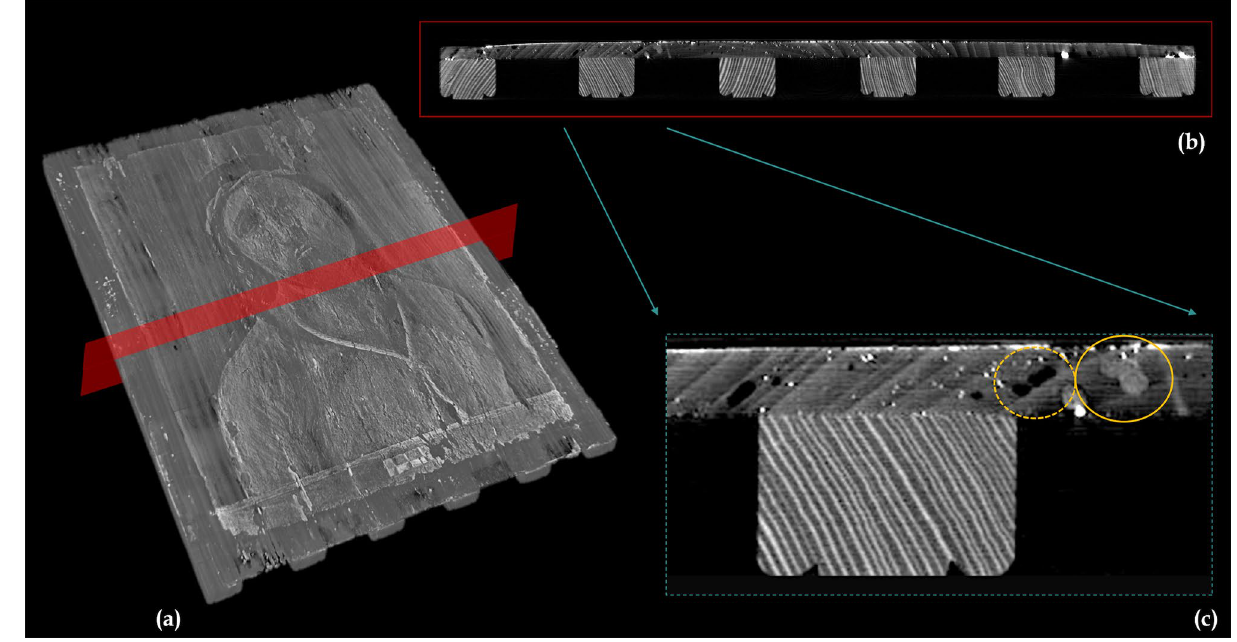
Figure 2. Tomographic analysis of the painting support. ( a ) 3D rendering of the entire tomographic volume and the virtual plane analysed (in red). ( b ) The corresponding tomographic slice shows the massive cradling, slim support, and extremely thin painting layers. ( c ) A detail of the previous section where several woodworm tunnels are visible, some are empty, and some have been filled with dust and wood residues (highlighted with dashed and continuous yellow